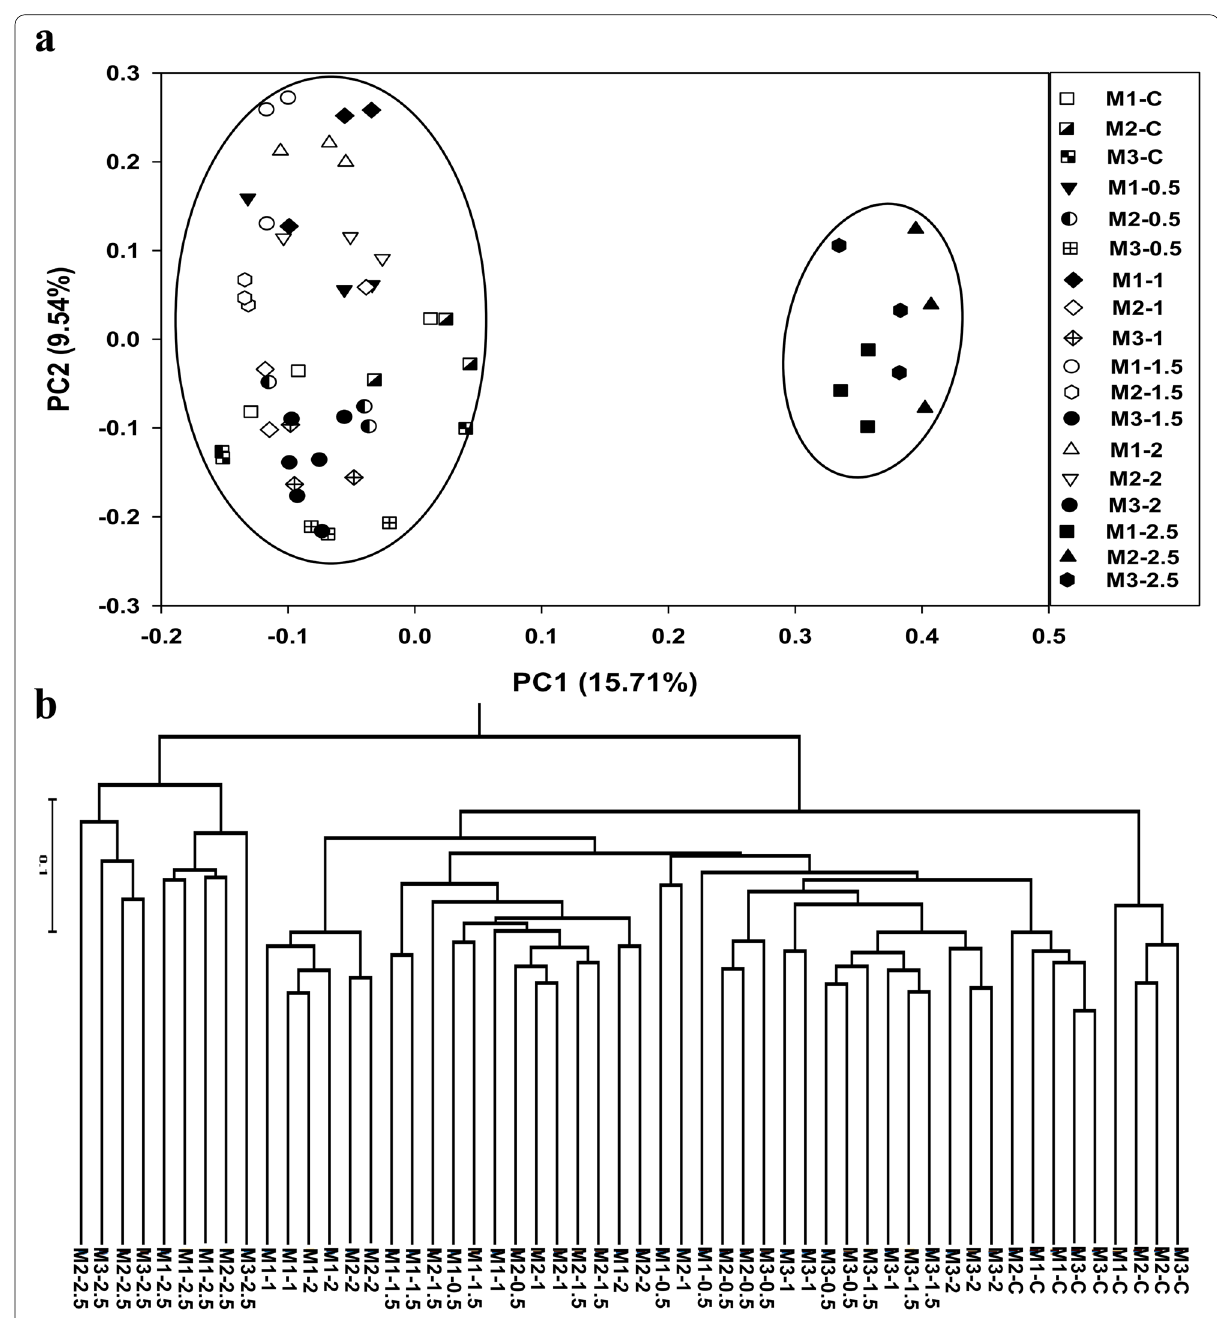
Fig. 3 Principal coordinate analysis (PCoA) and hierarchical clustering of bacterial communities in the non-amended and sclerotia-amended soil samples within rice-rapeseed rotation field soil amended with different doses of R. solani sclerotia. M1, M2, and M3 represent 1 st month, 2 nd month, and 3 rd month while C shows the non-amended samples. Moreover, 0.5, 1, 1.5, 2 and 2.5 denotes the different dose of sclerotia in gram amended in